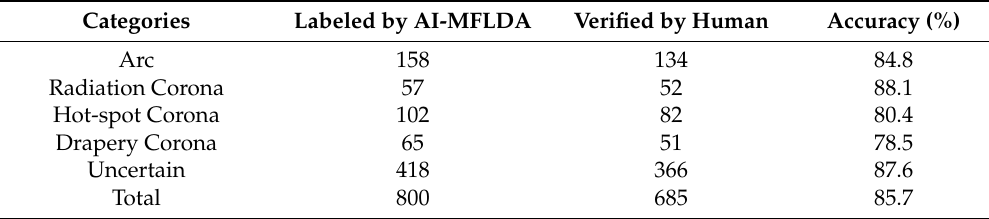
Table 6. Classification results by AI-MFLDA and human experts on the 800 unlabeled aurora images.